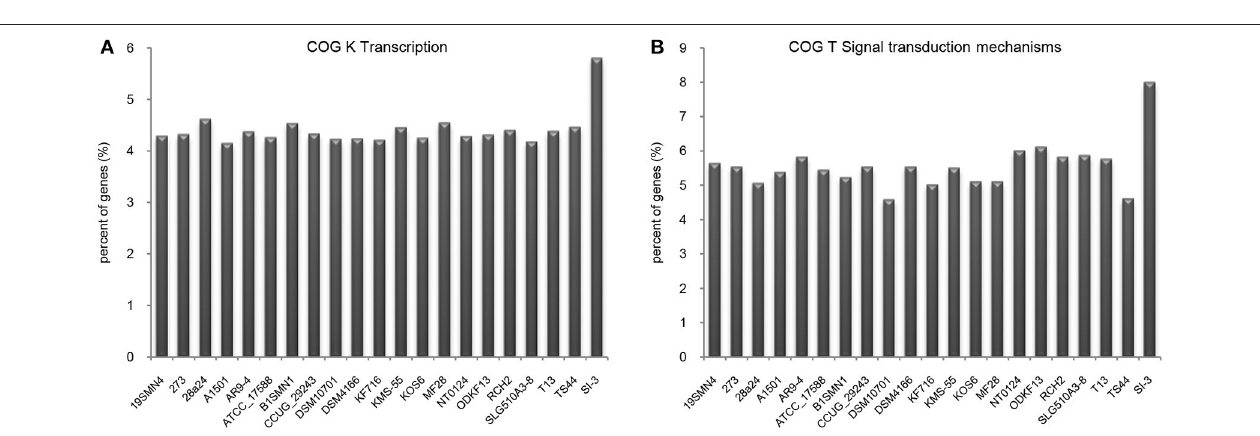
FIGURE 5 | Enhanced transcription and signal transduction network in Pseudomonas sp. strain SI-3. The proportions of genes assigned into COG K (A) and COG T (B) categories were normalized to the total gene number of all COG categories in each strain. pathways of SI-3 were close to the averages. Specifically, pathways gene number of the corresponding KEGG pathway of all 21 with relative gene contents lower than 0.8 and higher than 1.2 strains. All KEGG pathways of SI-3 were ranked based on were presented considering the significant differences relative gene contents and the gene numbers of most KEGG